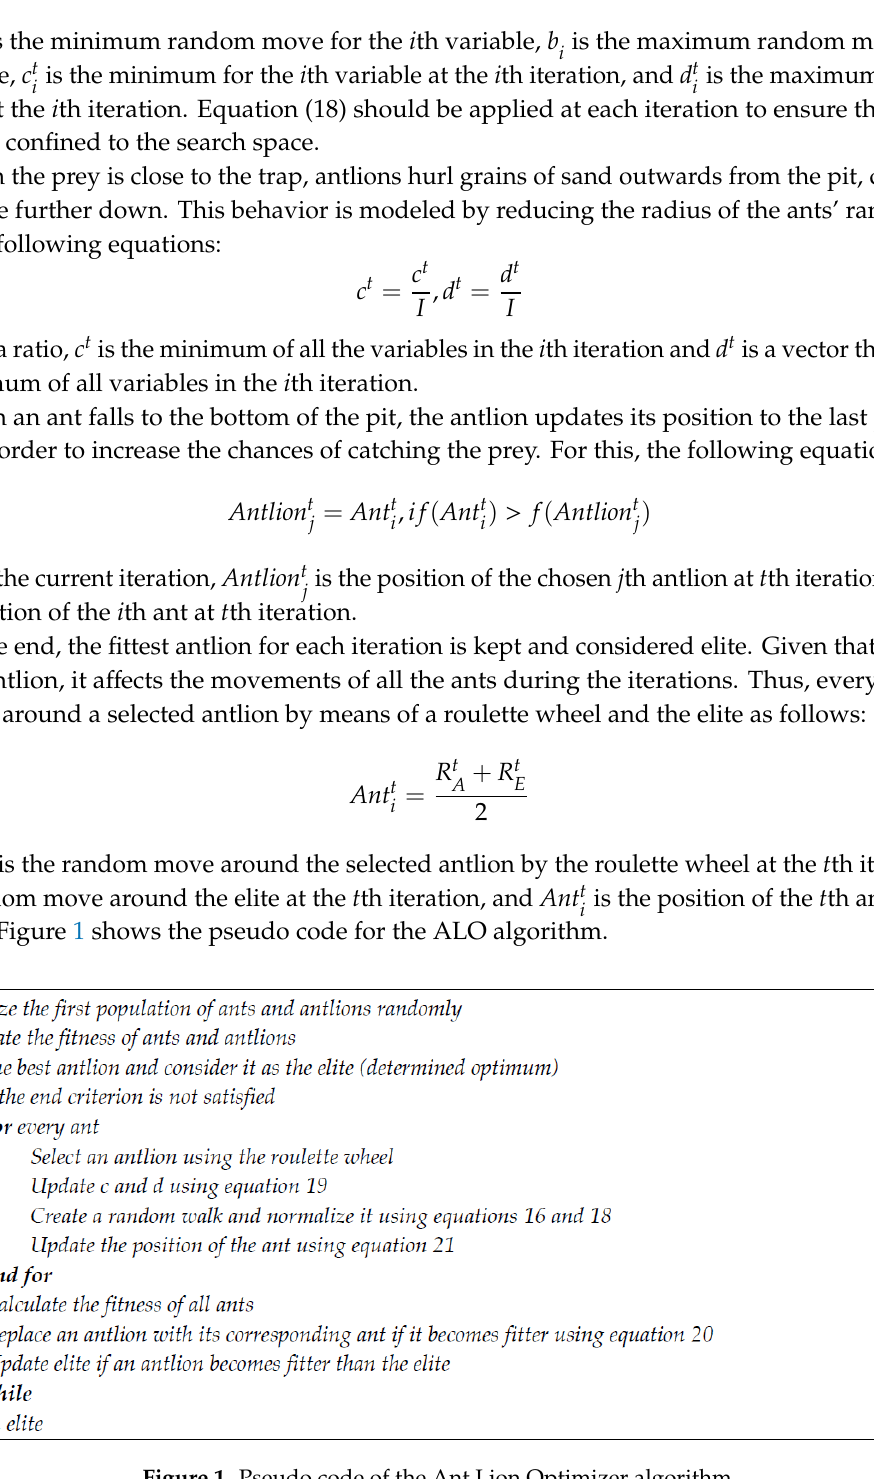
Figure 1. Pseudo code of the Ant Lion Optimizer algorithm.